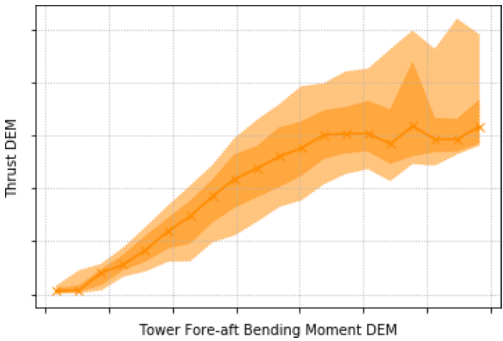
Figure 9. Thrust DEM vs. tower fore–aft bending moment